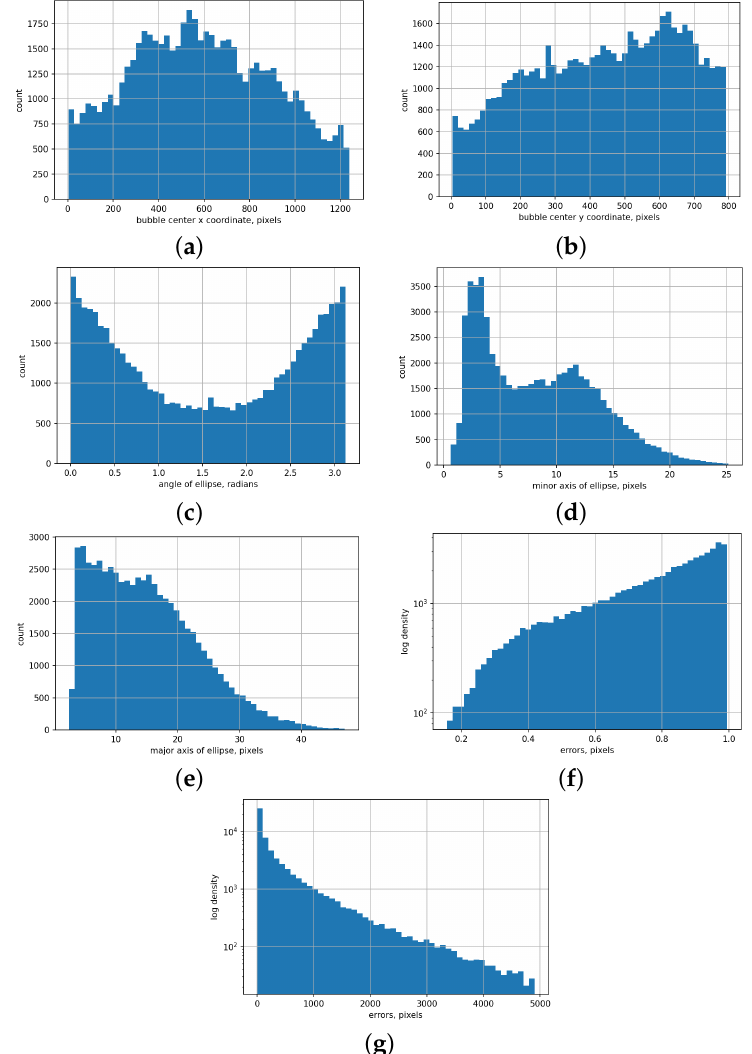
Figure 11. Basic distributions of ellipse parameters: ( a ) horizontal distribution of bubble centers; ( b ) vertical distribution of bubble centers; ( c ) distribution according to the angle of inclination of the semi-major axis; ( d ) minor axis distribution; ( e ) major axis distribution; ( f ) eccentricity; ( g ) error